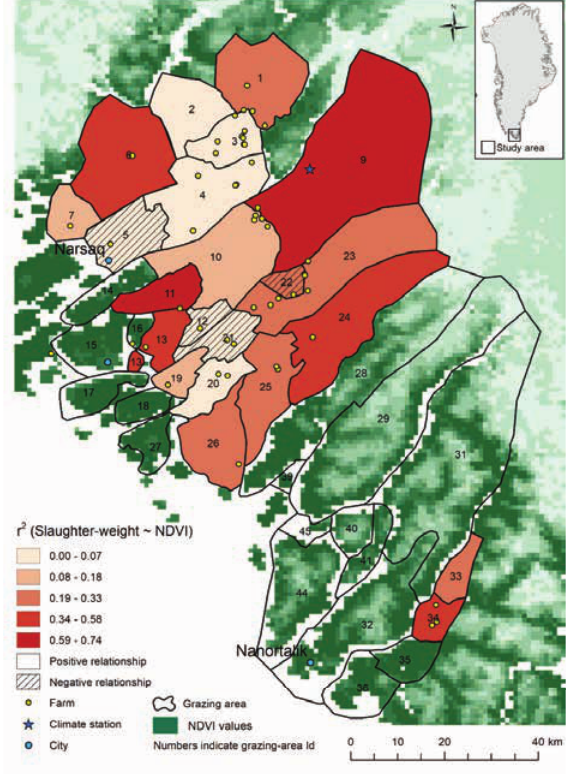
Figure 2: Mean and SD of NDVI per grazing area for years 2010-2017. Top and bottom horizontal bars represent maximum and minimum, respectively. Different letters denote significant differences with P <